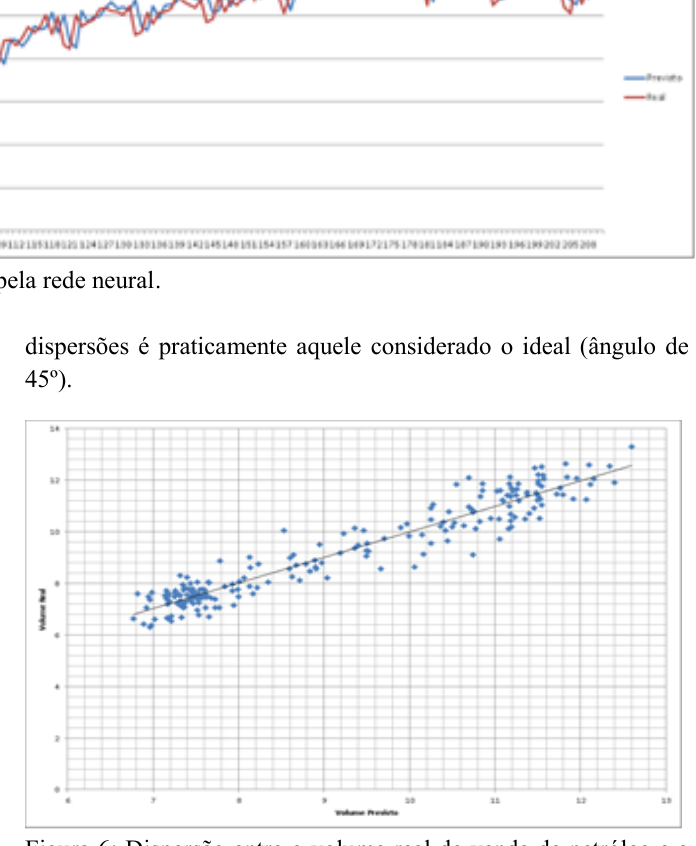
Figura 6: Dispersão entre o volume real de venda de petróleo e a previsão deste índice pela rede